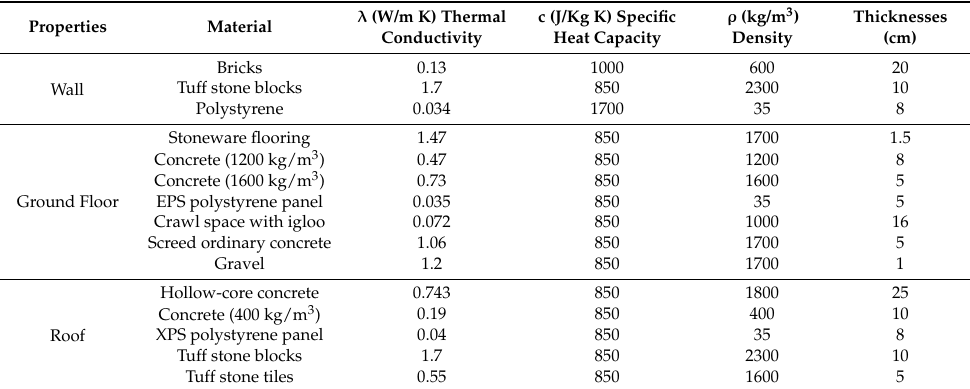
Table 4. Thermo-physical properties of building